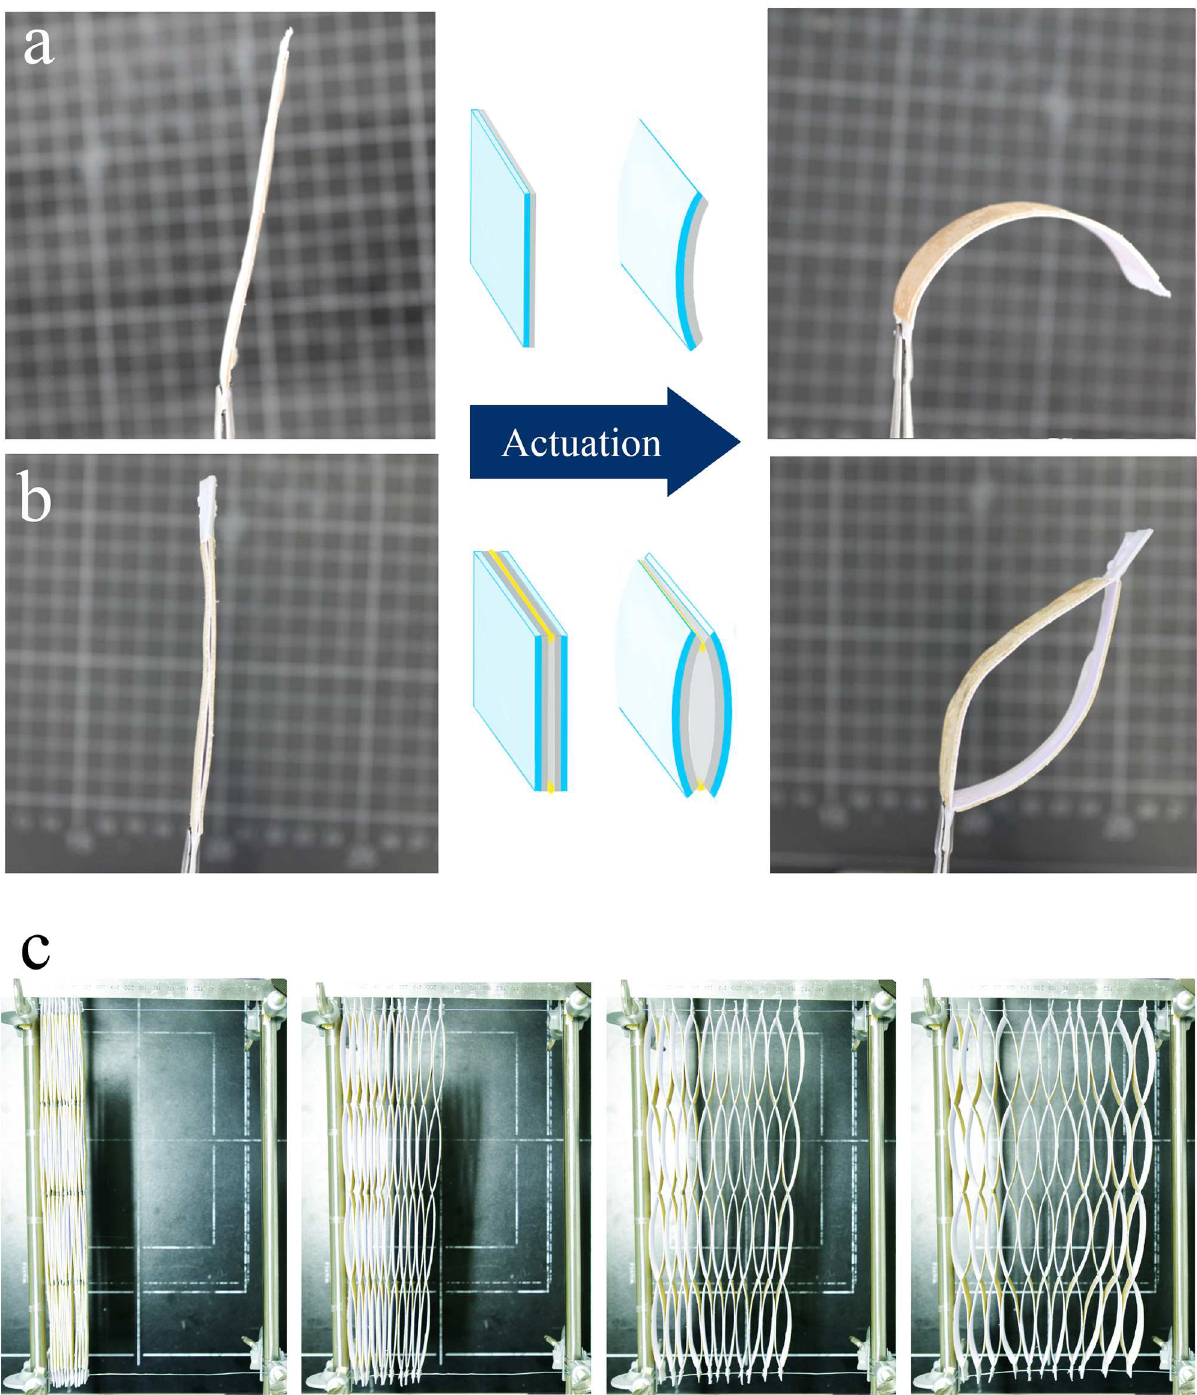
Fig 9. Passive hydro-actuation of bio-inspired bilayer-honeycomb device. Initial (left) and final actuated state (right) of the passive hydro-actuation upon changing the relative humidity from 50 to 95% are depicted at different levels of the design; (a) A bilayer made up of spruce veneer (active layer) glued to a thick paper (passive layer), bends upon anisotropicswellingof the spruce veneer in the direction perpendicular to the cellulosefibrils orientation. (b) Two of such bilayers attached together, constructs a cell-like structure that can open/ closes upon changes in the relative humidity. (c) Scaling up the bilayer-cellconcept into a hydro-actuated honeycomb prototype that expands up to 5 fold upon actuation (sequential images after 0, 2, 4 and 16 hours of exposure to 95%RH)